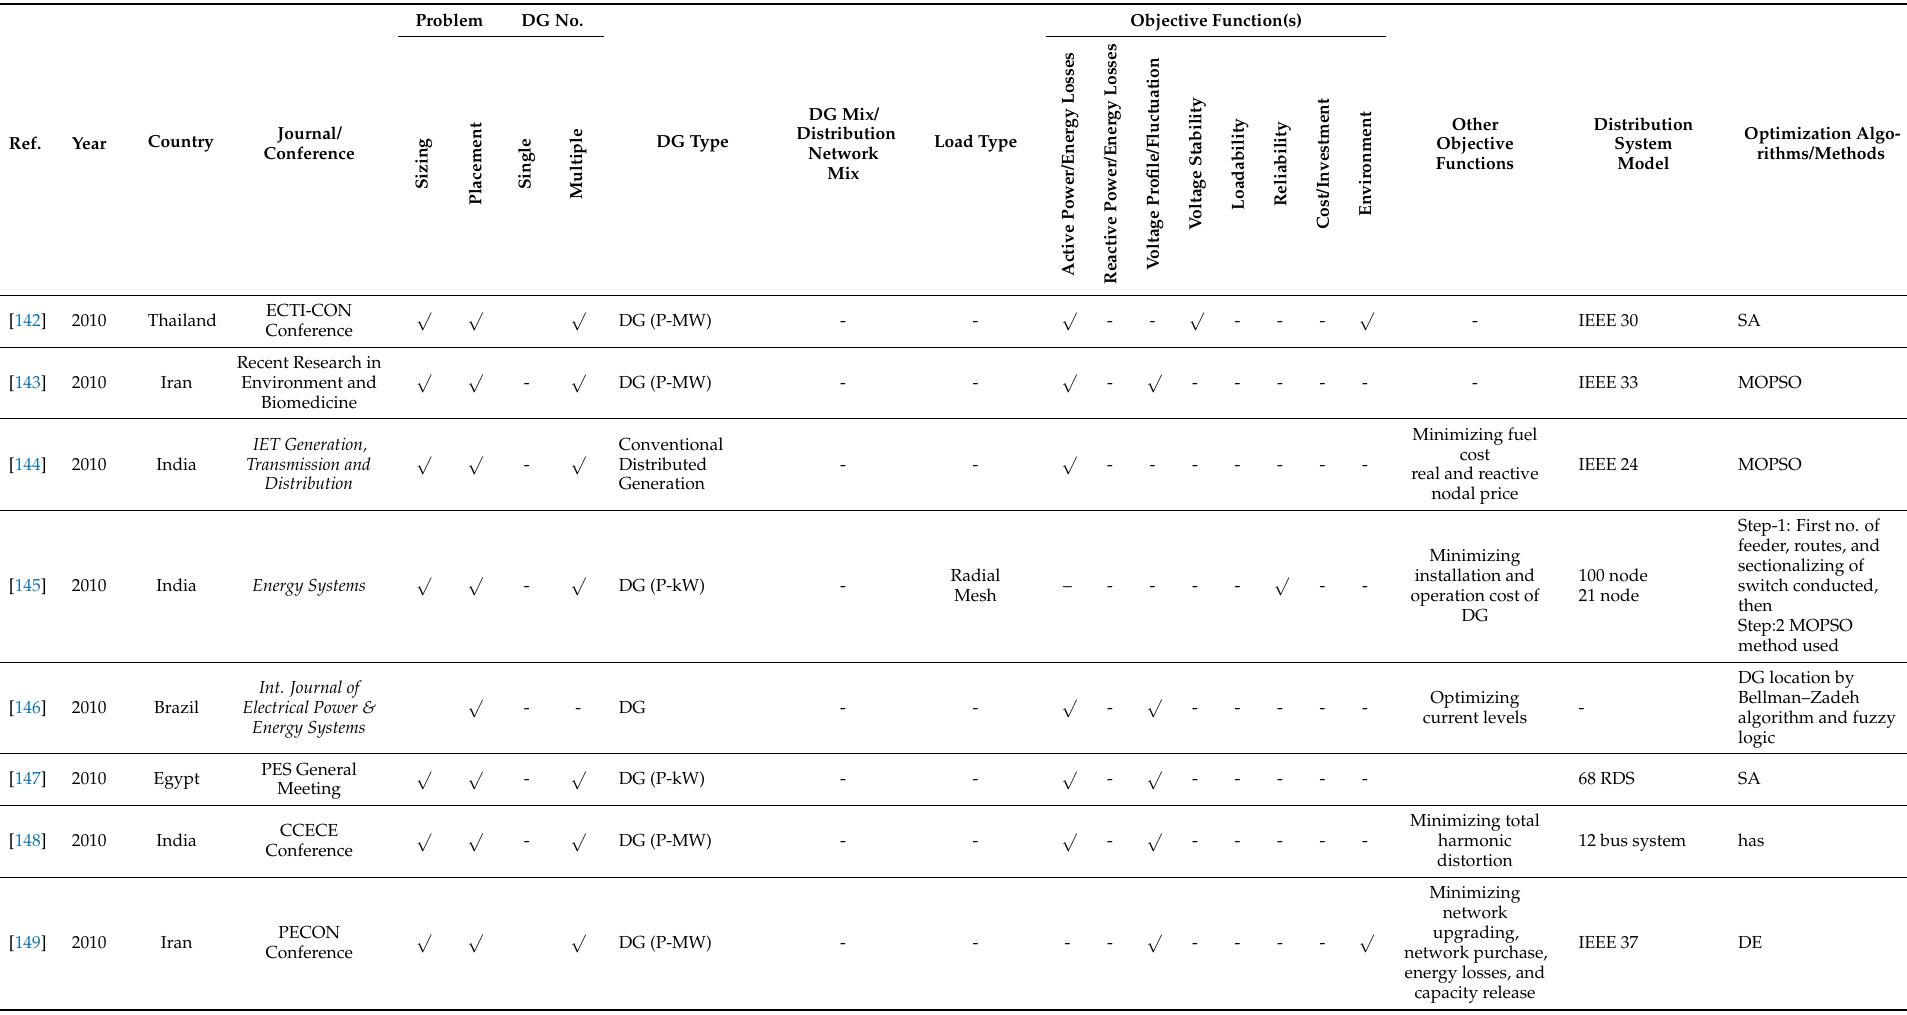
DG location by Bellman–Zadeh algorithm and fuzzy